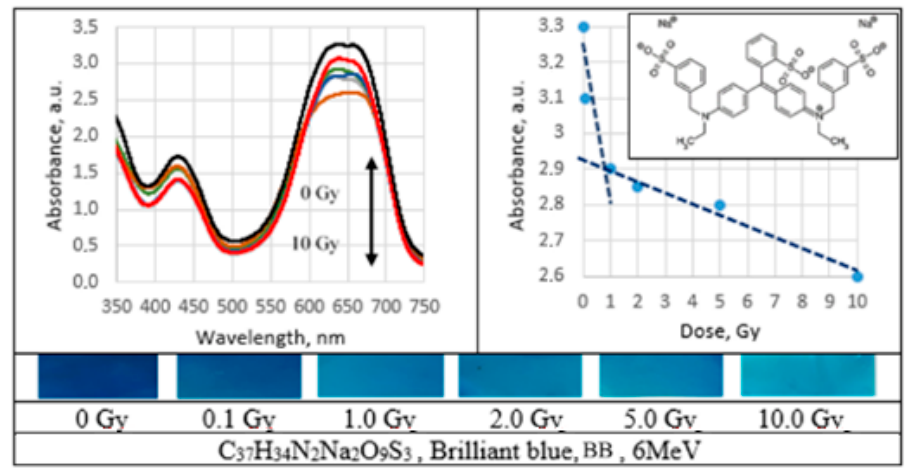
Figure 6. Absorbance spectra and sensitivity of the irradiated xylenol orange films.